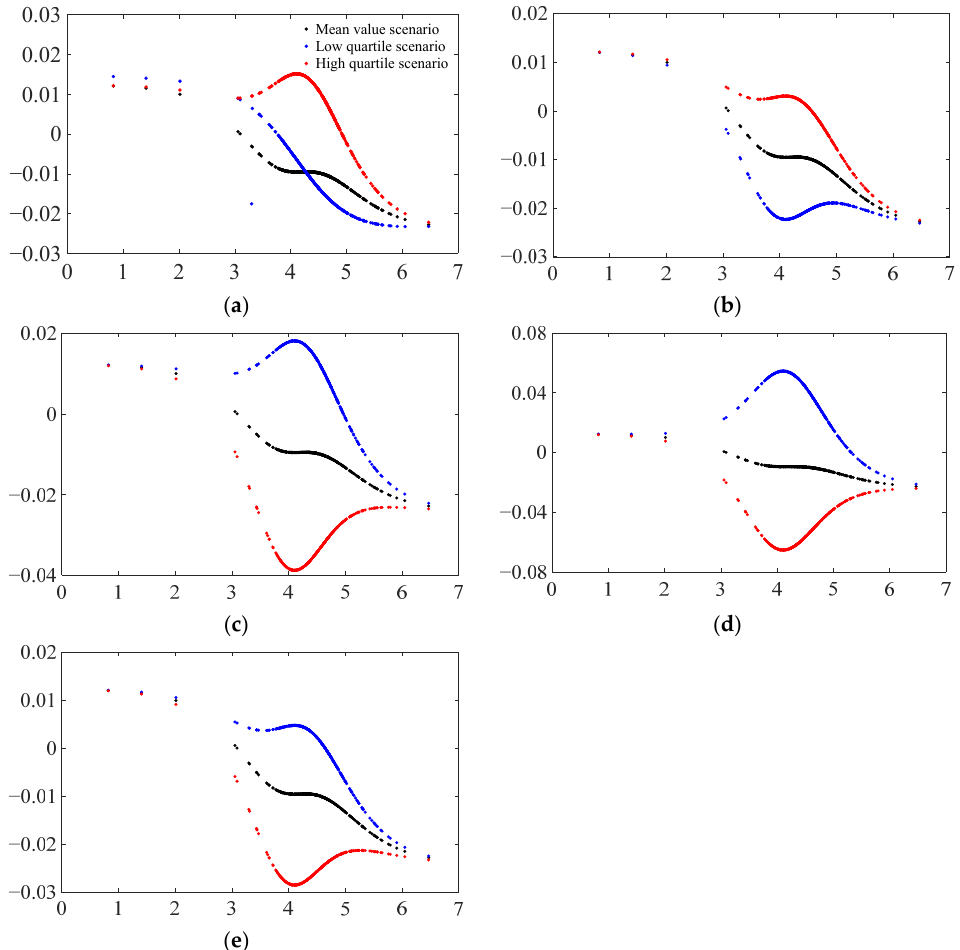
Figure 3. Nonlinear carbon emission effects of EPU under different values of control variables. Subplots ( a – e ) show the results for the control variables, level of economic development, financial development status, industrial structure, government spending, and environmental regulation, in that order.